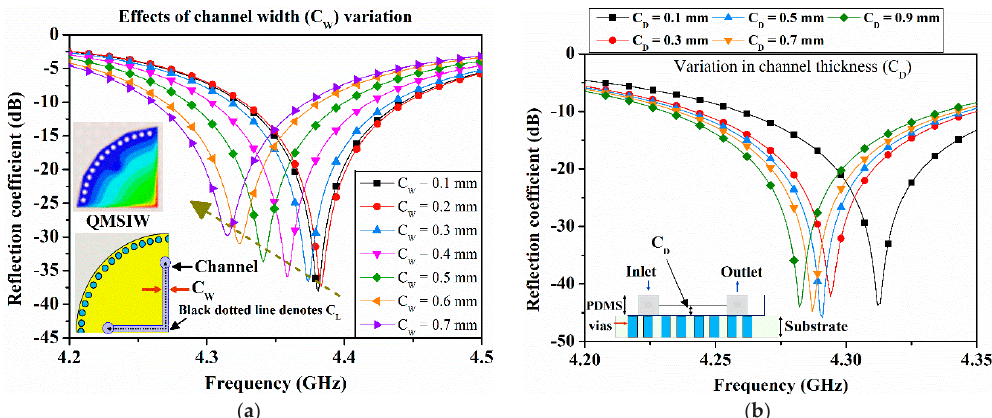
Figure 3. Simulated reflection coefficient of port 1 (S 11 ) for a variation in ( a ) the channel width (C W ) when the first microfluidic channel is filled with diluted ethanol ( ε r = 52 and tan δ = 0.35), and ( b ) the channel depth (C D ) when the first microfluidic channel is filled with diluted ethanol ( ε r = 52). QMSIW resonance frequency with empty microfluidic channels = 4.55 GHz, which was considered as the reference throughout this